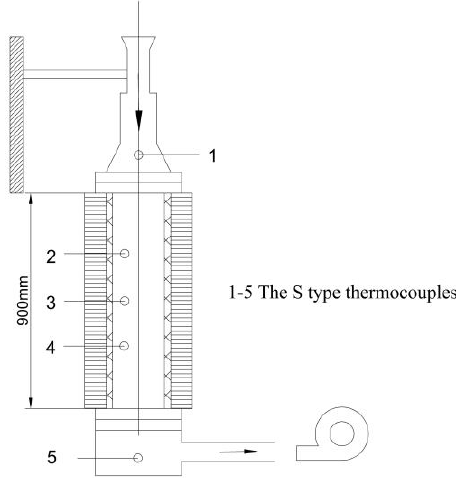
Figure 3. Schematic of experimental design.